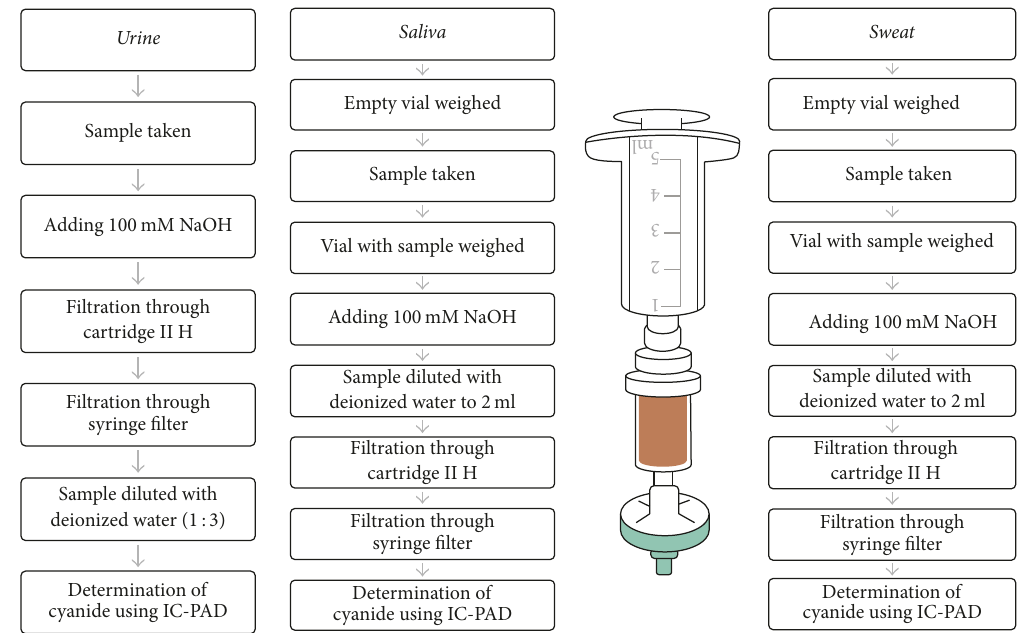
Figure 2: The process of sample preparation for